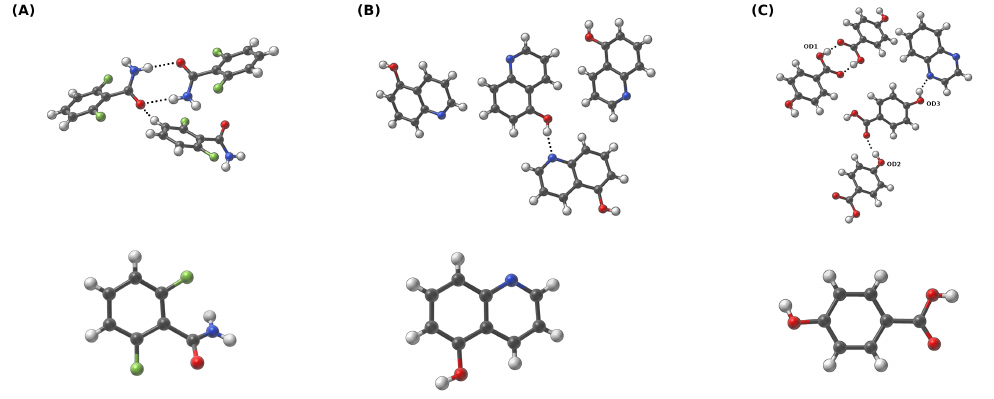
Figure 1. Crystalline (first row) and gaseous phases (second row) of ( A ) 2,6-difluorobenzamide, ( B ) 5-hydroxyquinoline, and ( C ) co-crystal of 4-hydroxybenzoic acid and quinoxaline. For clarity, the oxygen donor atoms for ( C ) are denoted as OD1, OD2 and OD3—this adopted nomenclature is used throughout the study. Dotted line indicates the intermolecular hydrogen bond. Color coding: